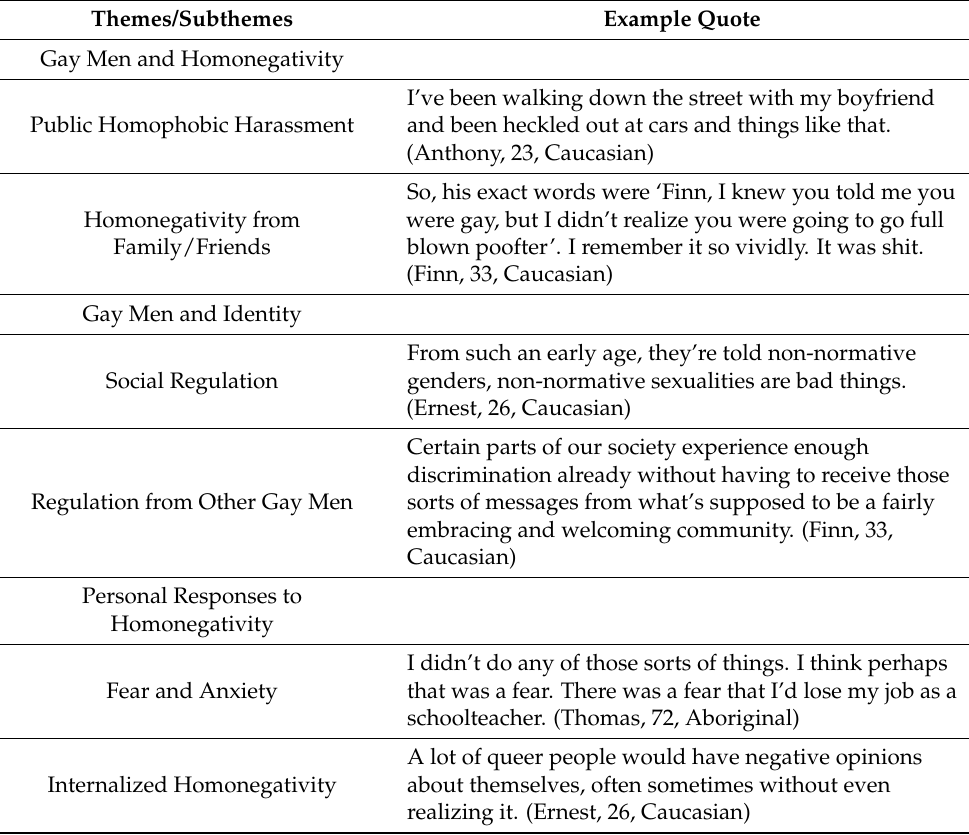
Table 2. Summary of emergent themes and subthemes from participants’